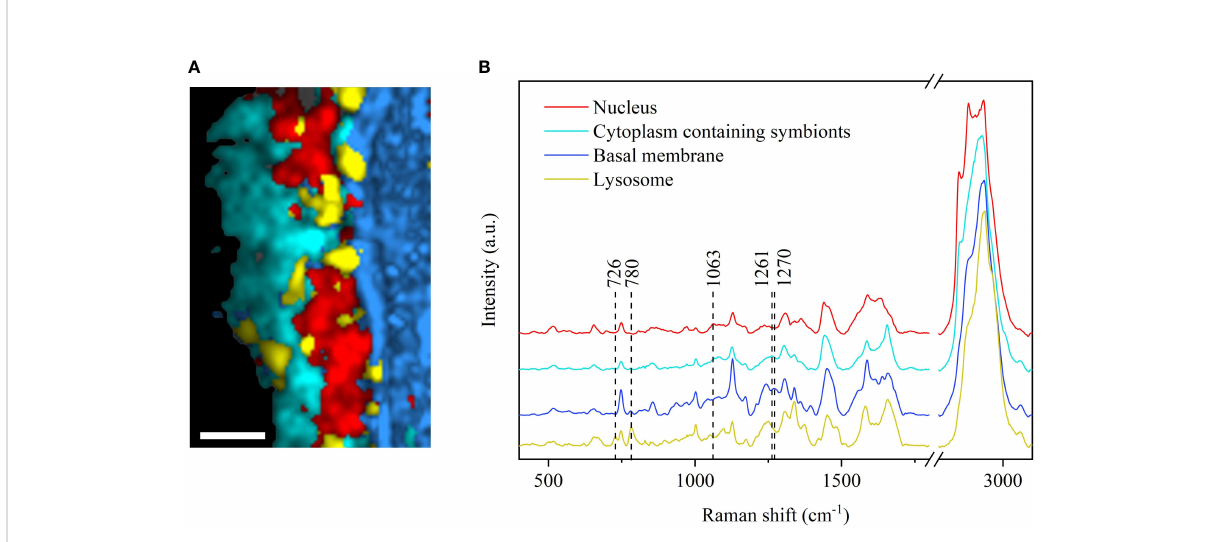
FIGURE 1 CRM imaging analysis of G . platifrons gills following the CS preservation method. (A) Raman imaging of gills showing the distribution of cellular components, including the nucleus (red), cytoplasm containing symbionts (cyan), basal membrane (blue), and lysosome (yellow). Scale bars: 8 µm. The bright fi eld corresponding to Raman imaging images were shown in Supplementary Figure S1. (B) Average Raman spectrum of the nucleus, cytoplasm containing symbionts, basal membrane, and